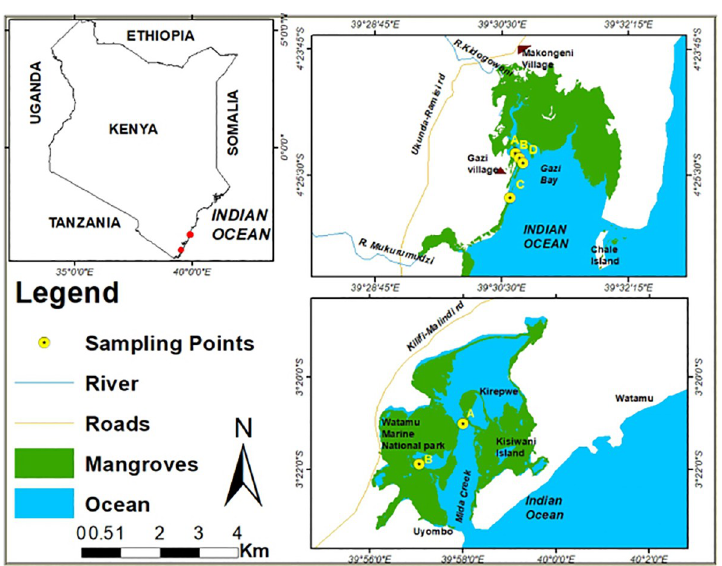
Fig 1. Map of Kenya (inset) with red dots highlighting the Sampling sites (Mida Creek and Gazi Bay). Circles at the sampling sites represents the sampling plots where the study was conducted.